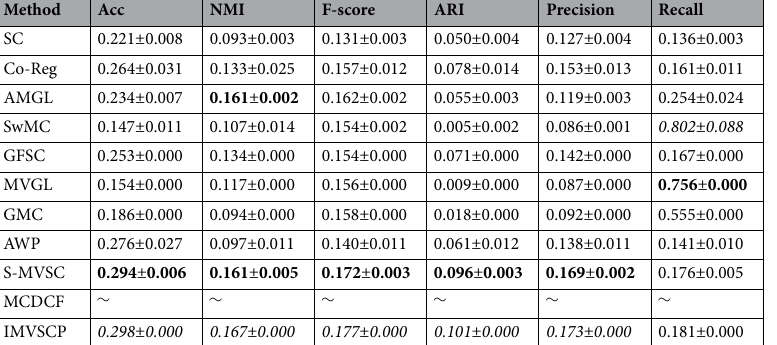
Table 6. Experimental results (mean standard deviation) on the NUS dataset. Significant values are in [bold/